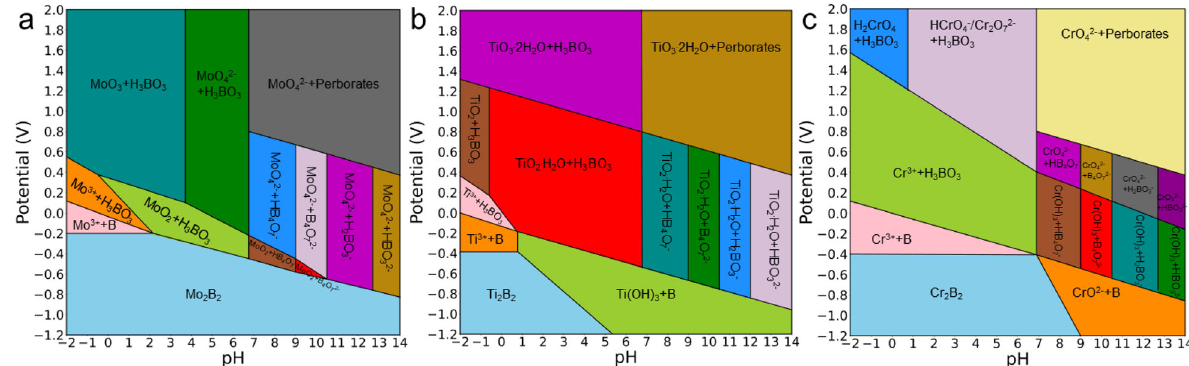
Fig. 6 Corrosion resistance of MBenes under electrochemical conditions. Computationally predicted Pourbaix diagrams of ( a ) Mo 2 B 2 , ( b ) Ti 2 B 2 , and ( c ) Cr 2 B 2 using 10 − 6 M concentration for aqueous species at 25